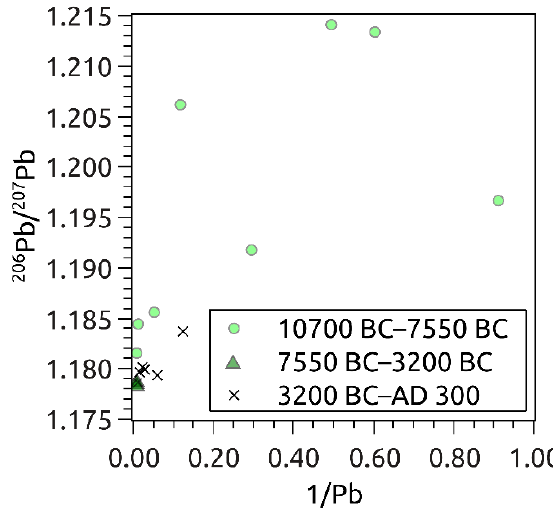
Figure 5. 1/Pb versus 206 Pb/ 207 Pb binary diagram, distinguishing the three periods discussed in this article. 206 Pb/ 207 Pb quotient was interpolated from the data in Table 2, then merged with Pb content from Table